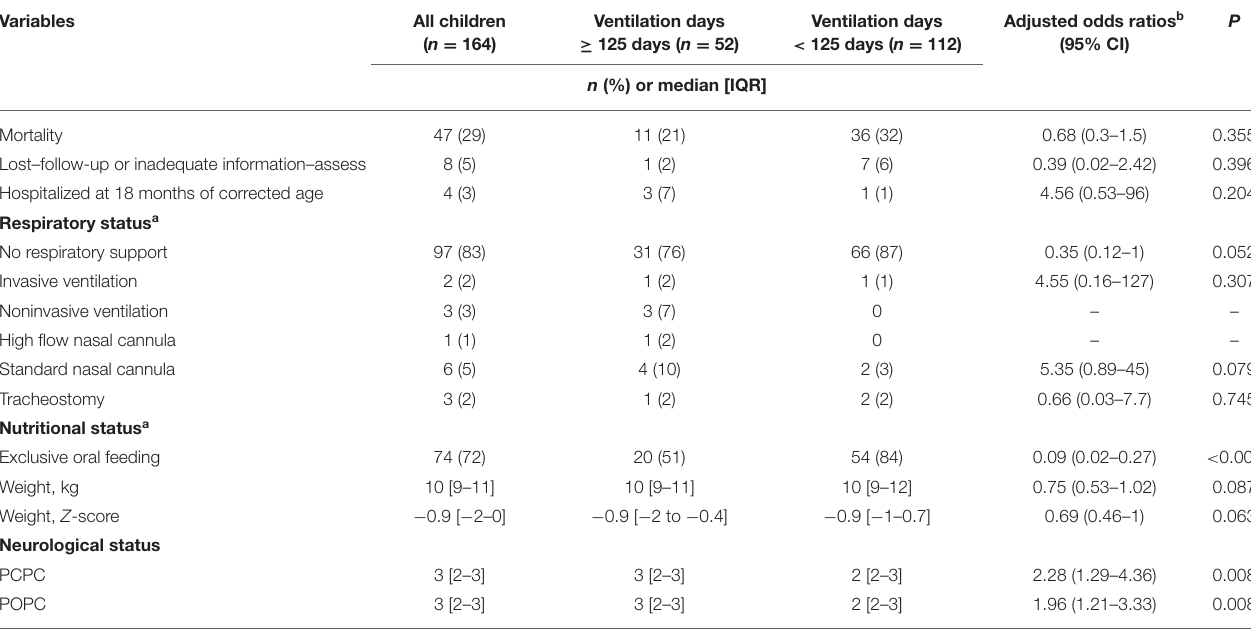
TABLE 3 | Outcomes at 18 months corrected age.